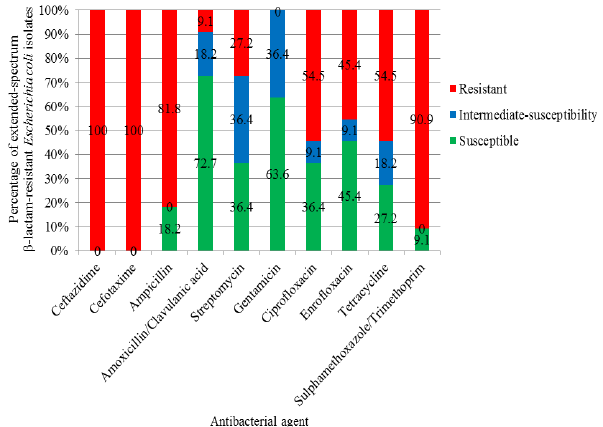
Fig. 2. Antibiogram of 11 generic extended-spectrum β-lactam- resistant Escherichia coli from dogs